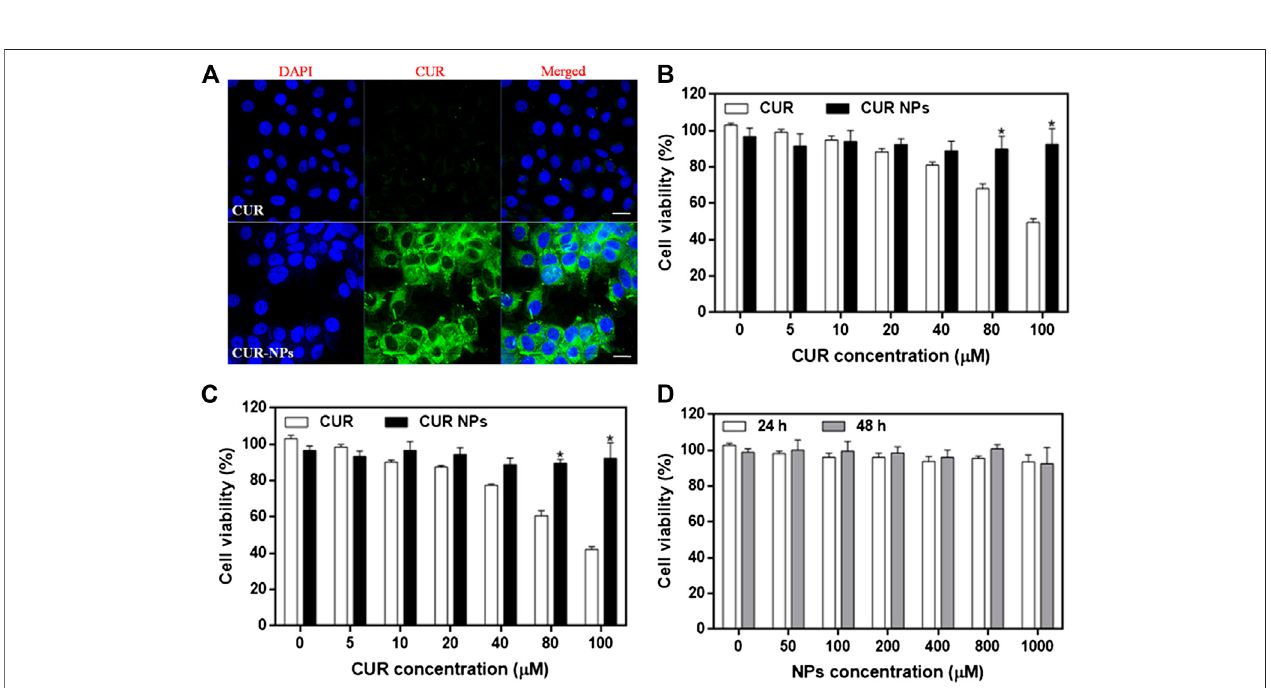
FIGURE 2 | Cellular uptake and cytotoxicity of CUR-NPs on cardiomyocytes (A) CLSM images of CUR and CUR-NPs taken by cardiomyocytes. Scale bar 50 μ m (B) TheeffectofCURandCUR-NPsontheviabilityofcardiomyocytesafter24 hstimulation.* p < 0.05 vs CURgroup (C) TheeffectofCURandCUR-NPsontheviability of cardiomyocytes after 48 h stimulation. * p < 0.05 vs CUR group (D) Effect of blank nanocarrier on viability of cardiomyocytes.